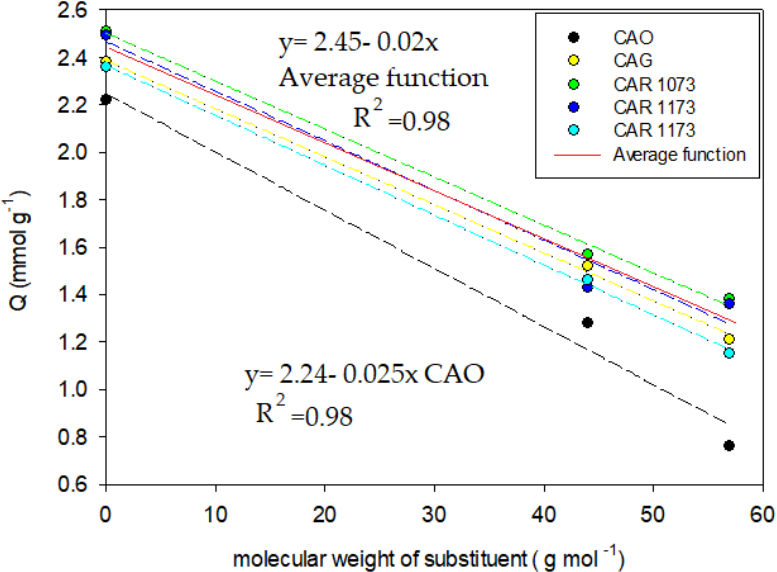
Figure 9. Relation between the molecular weight of the substituent and the adsorption capacity of the adsorbates on the activated carbons CAO, CAG, CAR1073, CAR1173, and CAR1273.